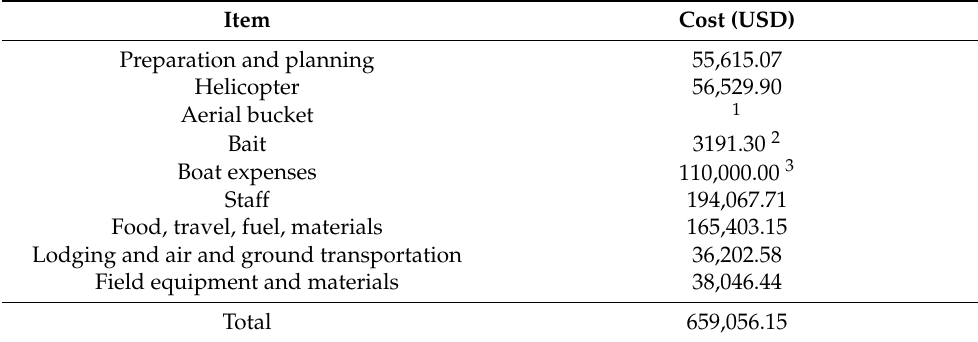
Table 2. Cost estimates of the mouse eradication on San Benito Oeste